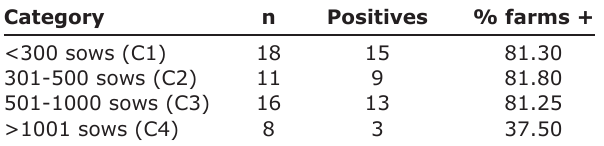
Table-3: Categorization of farms in quartiles according to herd breeding size, number of Brachyspira spp. positive farms, and percentage of positive farms in each